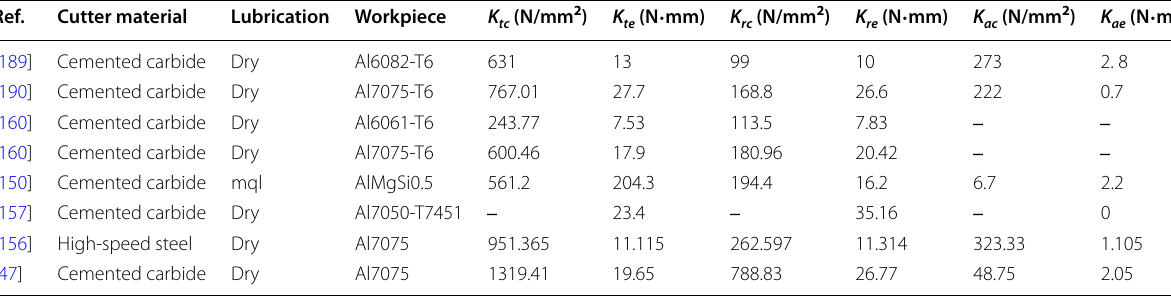
Table 5 Model coefficients of milling force for aerospace aluminum alloy Ref.